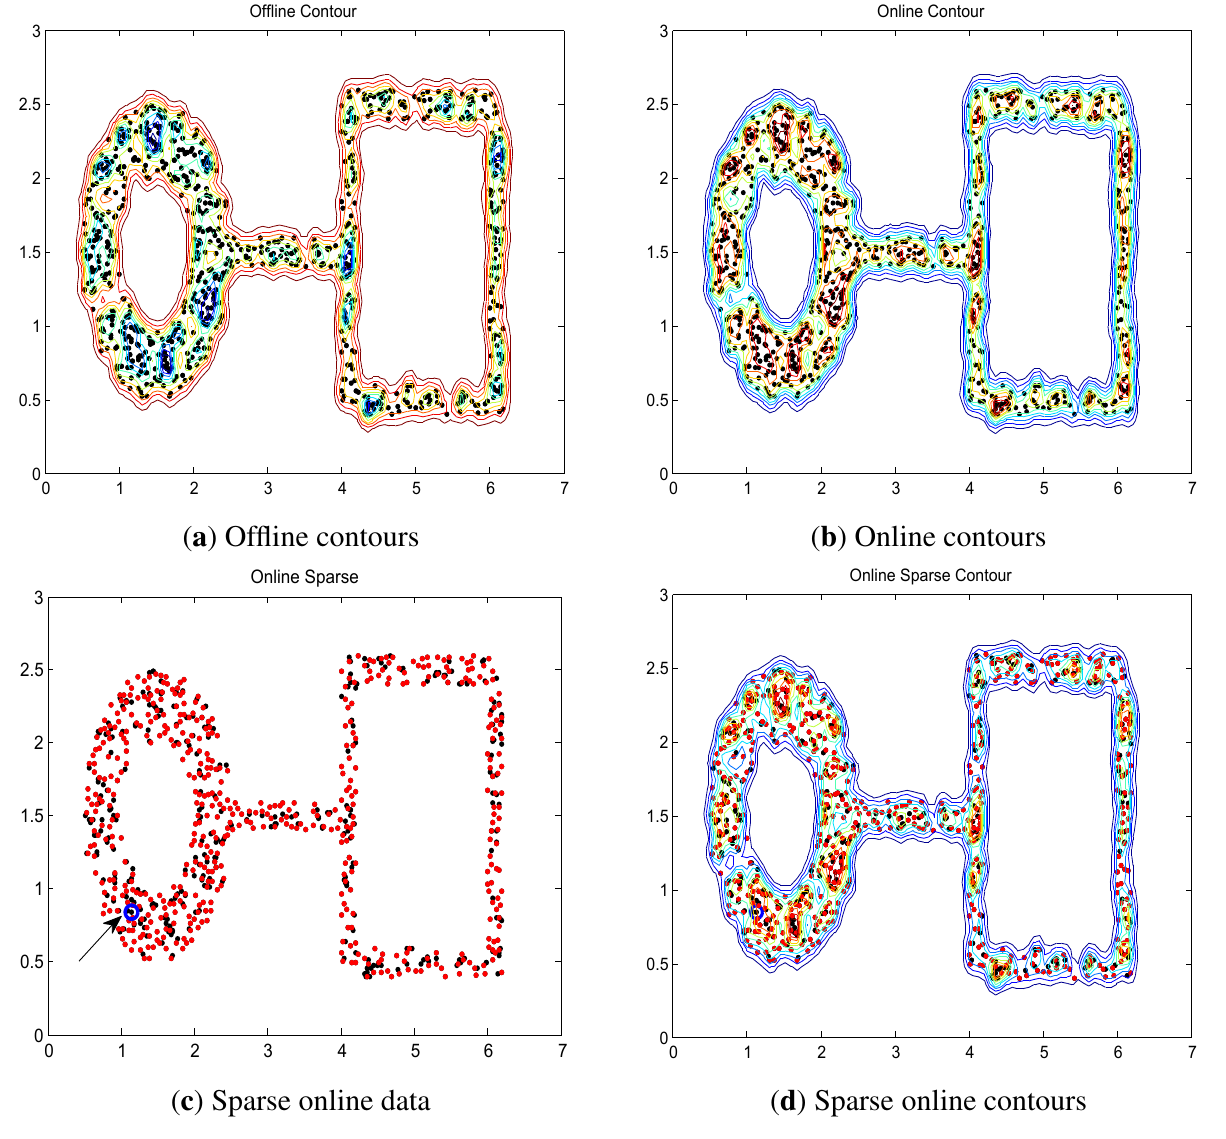
Figure 6. Offline, online LS-OC-SVM and sparse online LS-OC-SVM results of “ring-line-square”. ( a ) The contours when all the training date are learned as one batch offline; ( b ) The contours when the training data are learned via online LS-OC-SVM; ( c ) The blue circle (pointed out by the arrow) shows the original dictionary. The red points show the 534 new data included into the dictionary via sparse online LS-OC-SVM; ( d ) The contours when the training data are learned via sparse online